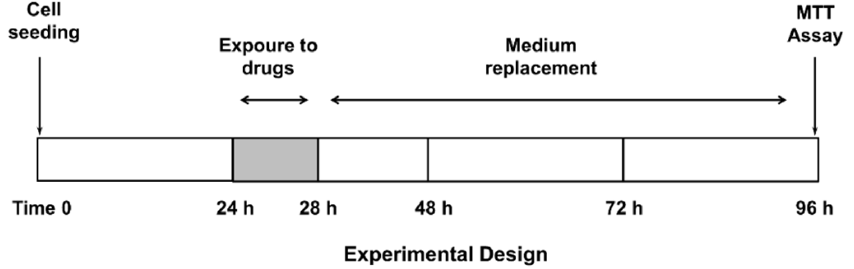
Figure 1. Treatment schedule chosen to assess the chemosensitizing properties of caryophyllane sesquiterpenes.